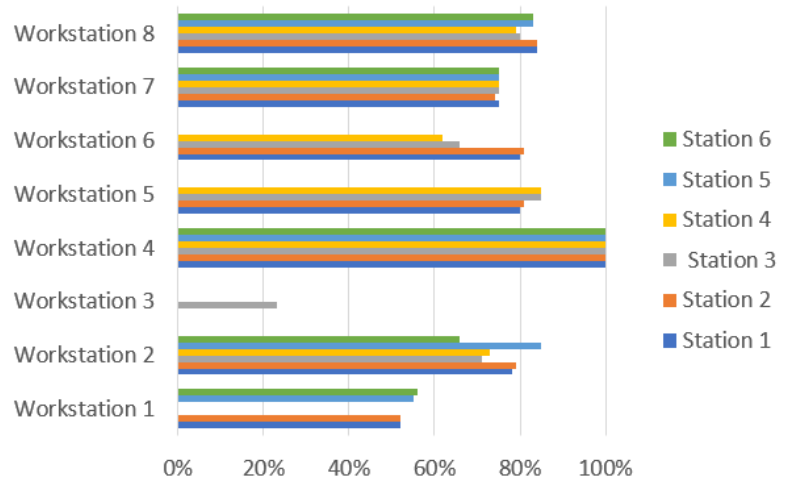
Figure 9. Velocity percentages for each welding